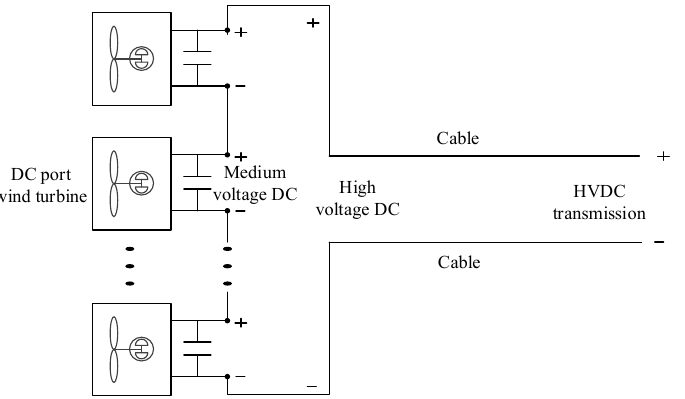
Figure 11. Scheme 8-HVDC transmission scheme for DC-port wind turbine connected in series.